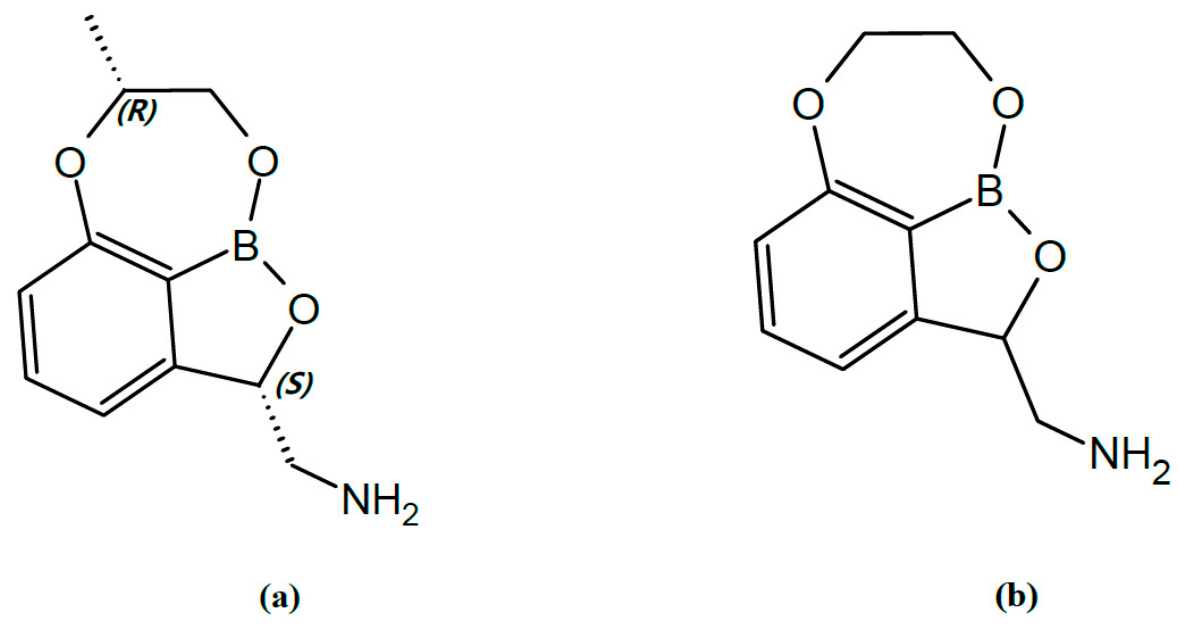
Figure 1. Chemical structures of DA-7010 and the internal standard (IS): ( a ) DA-7010; ( b ) the